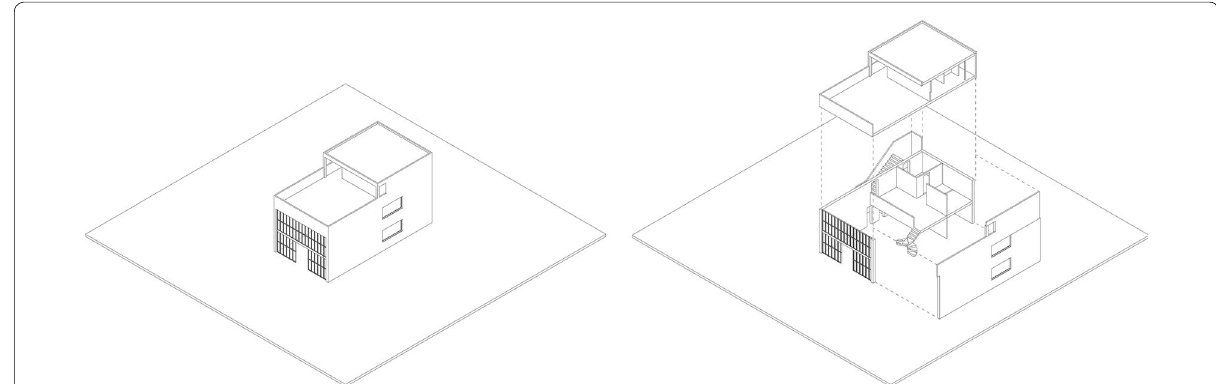
Fig. 1 LeCorbusier’s 1919 Maison